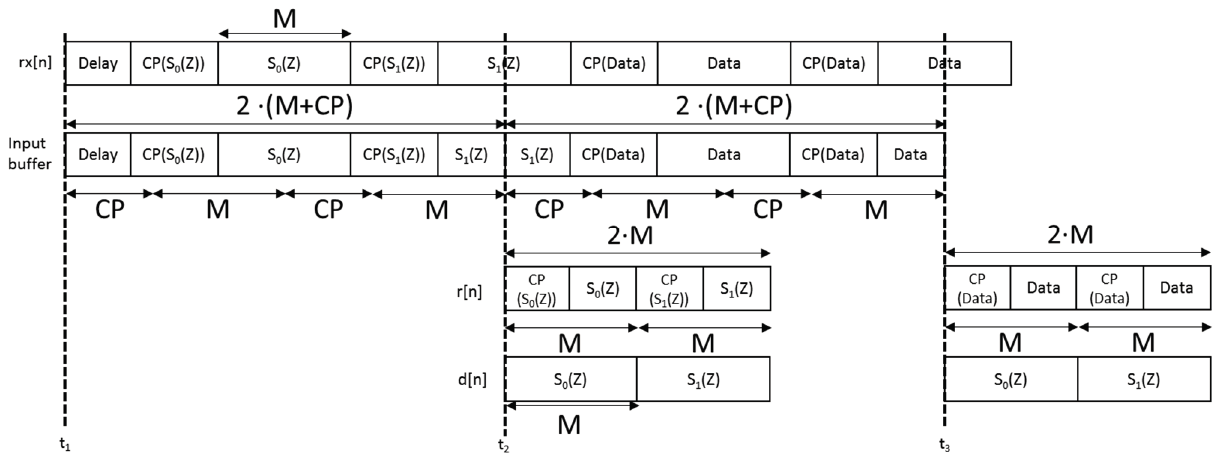
Figure 6. Scheme of the CP removal process, and the corresponding input for the correlation